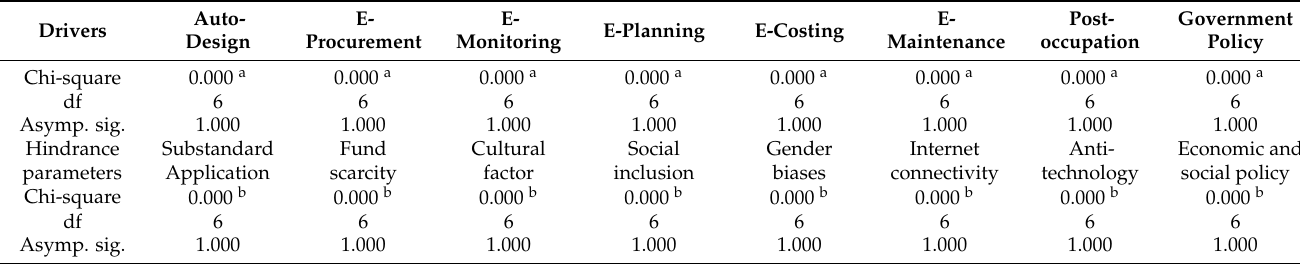
Table 6. Pearson’s Chi-Square Analysis Table on Hindrances in Achieving C4.0 and I4.0.